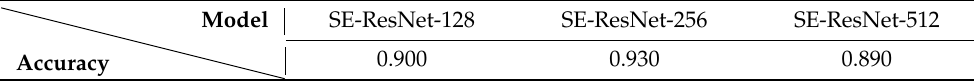
Table 1. The results of the three networks of the SE-ResNet model.